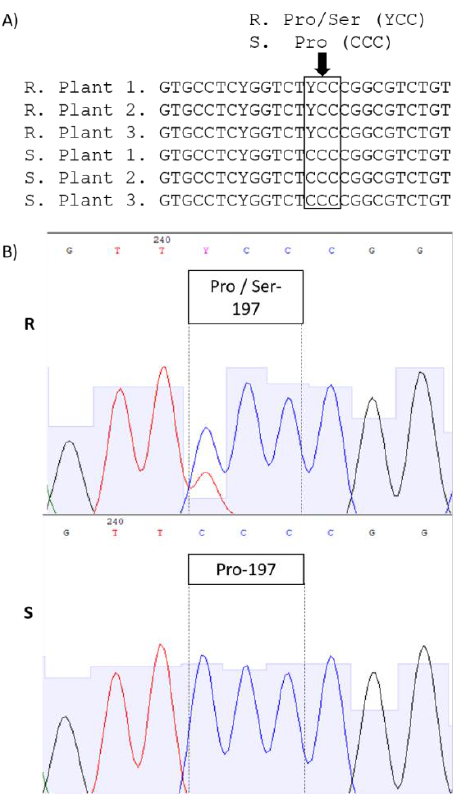
Figure 3. Nucleotide sequence of the ALS gene of Erigeron sumatrensis resistant (R) and susceptible (S) to ALS inhibitors. ( A ) Substitution of Ser for Pro in position 197. Letter Y represents base T or C. ( B ) Chromatogram demonstrating the heterozygosity found in the substitution of alleles containing CCC (plants S) and TCC or CCC plants R.